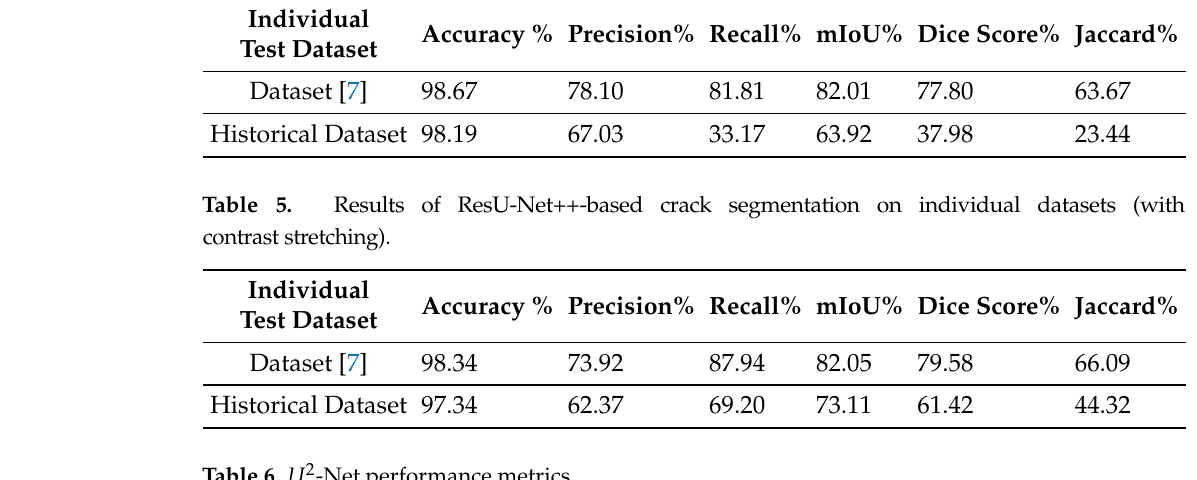
Table 6. U 2 -Net performance